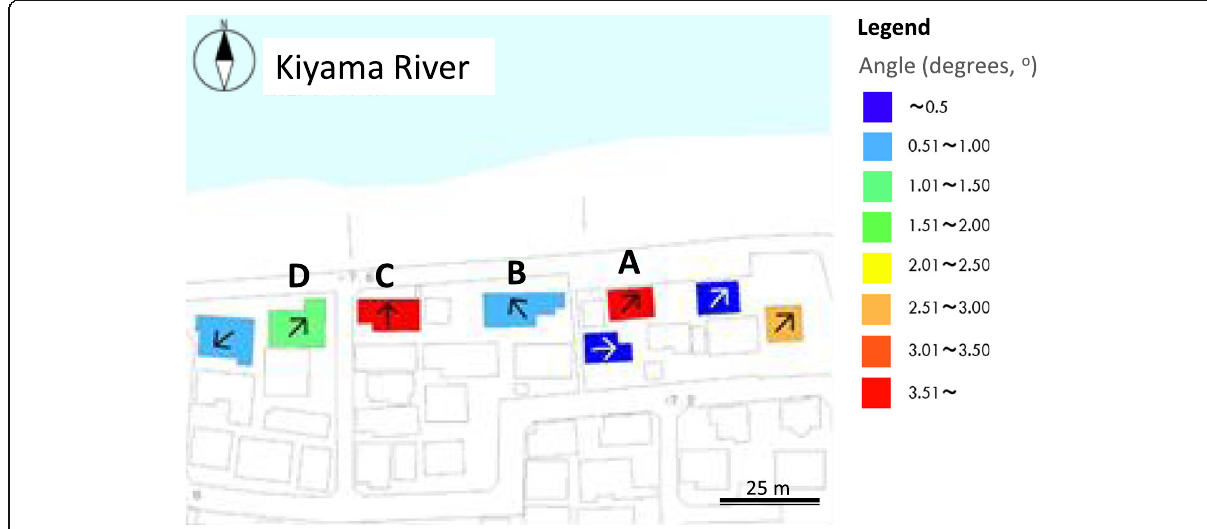
Fig. 8 The tilt angle and direction measurement result in Akitsu